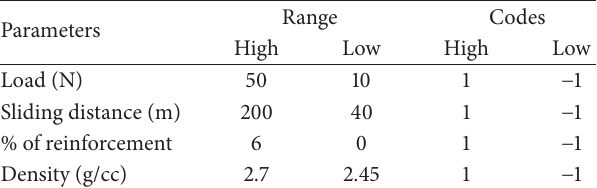
Table 3: Parameters and their control